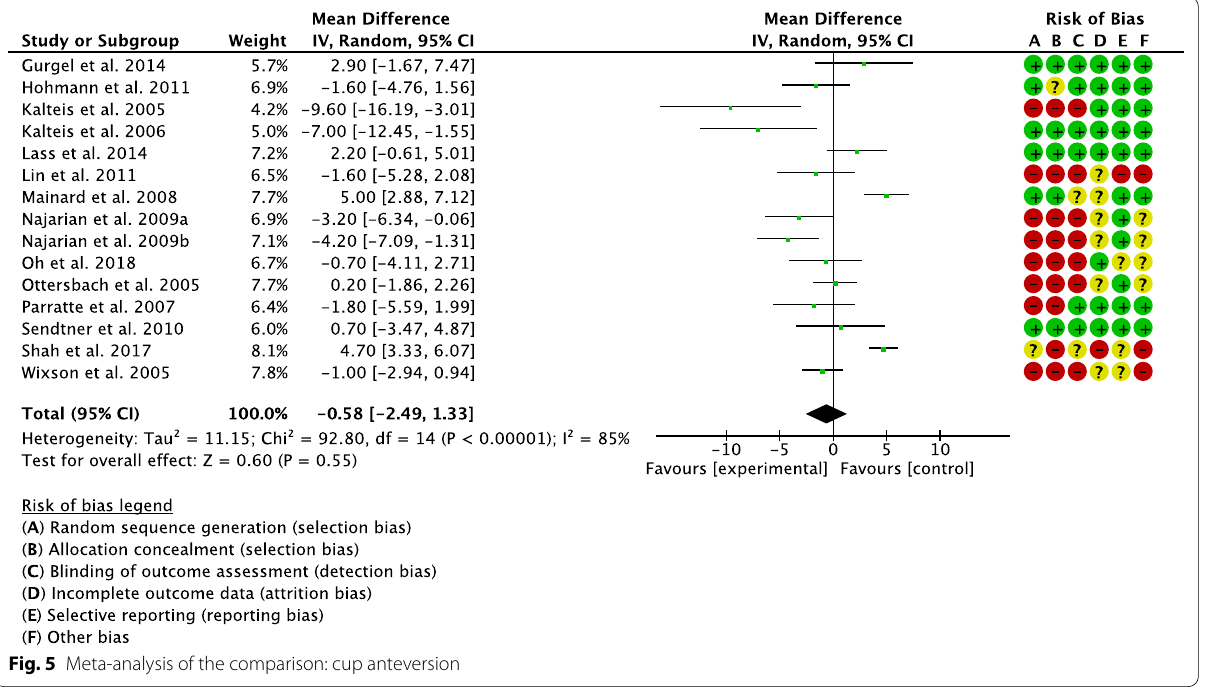
Fig. 5 Meta-analysis of the comparison: cup